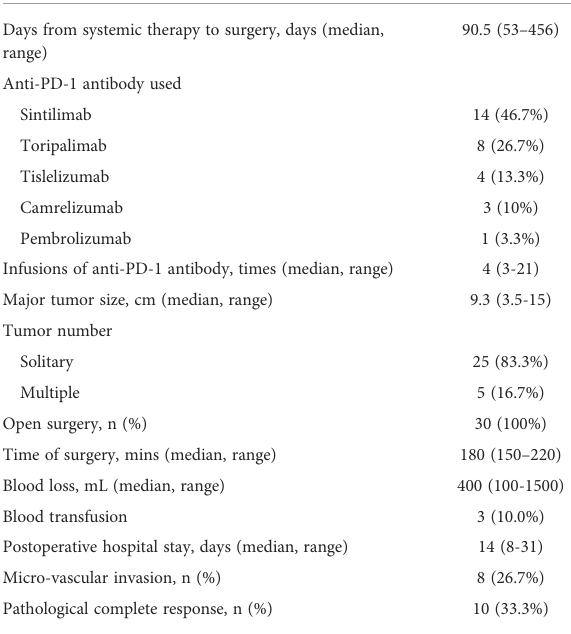
TABLE 3 Surgical and pathological features of patients receiving conversion surgery (n = 30).